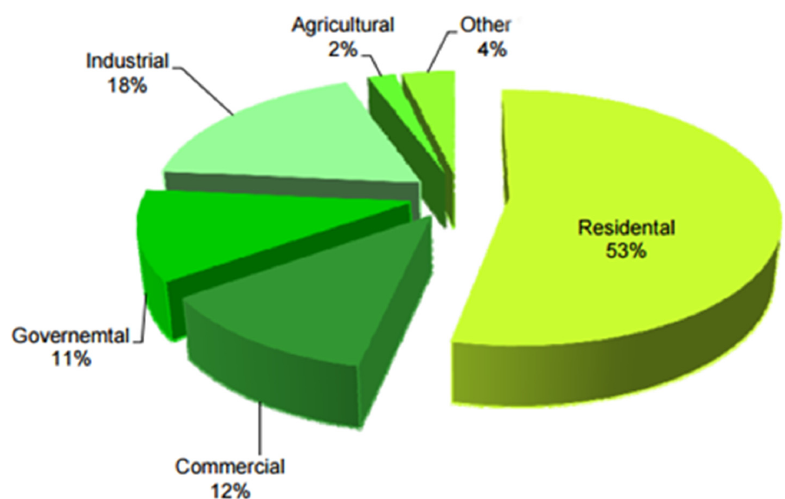
Figure 4. Electricity consumption by sector (Source: Ministry of Water and Electricity).